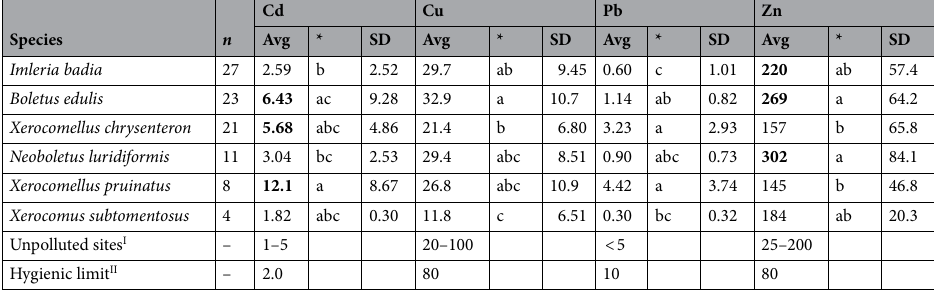
Table 2. Average contents of PTEs (mg/kg) in the studied mushrooms compared to the selected limits; bold values are above both limits. *Different lower-case letters indicate significant differences among species in PTEs contents. SD are standard deviations. I Range of usual PTE contents reported for the mushroom species